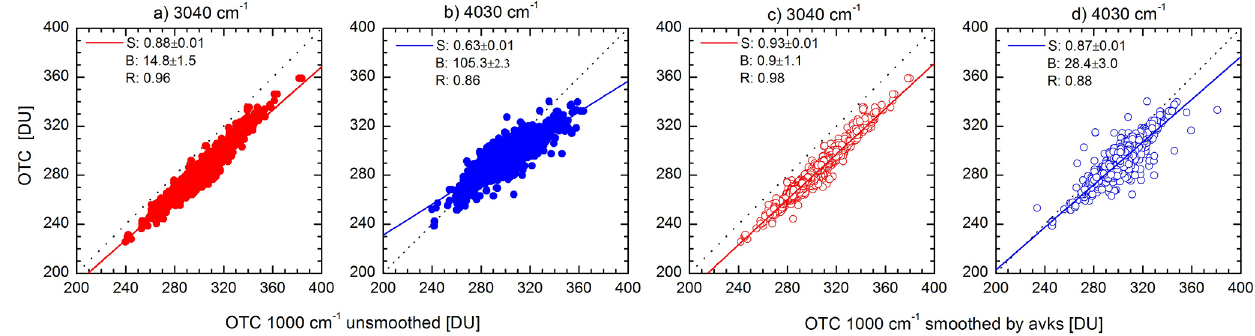
Figure 4. Scatter plots of OTC [DU] retrieved in the 3040cm − 1 region ( a , c , N = 2723) and in the 4030cm − 1 region ( b , d , N = 2300) versus 1000cm − 1 region unsmoothed and smoothed by the averaging kernels (avks) from 3040 to 4030cm − 1 O 3 retrievals. The black solid lines are the linear regression line of the least square fits, whose parameters are shown in the legend ( S and B are the slope and the bias of the regression fit, respectively, and R the correlation coefficient). The dotted lines are the diagonals ( x = y